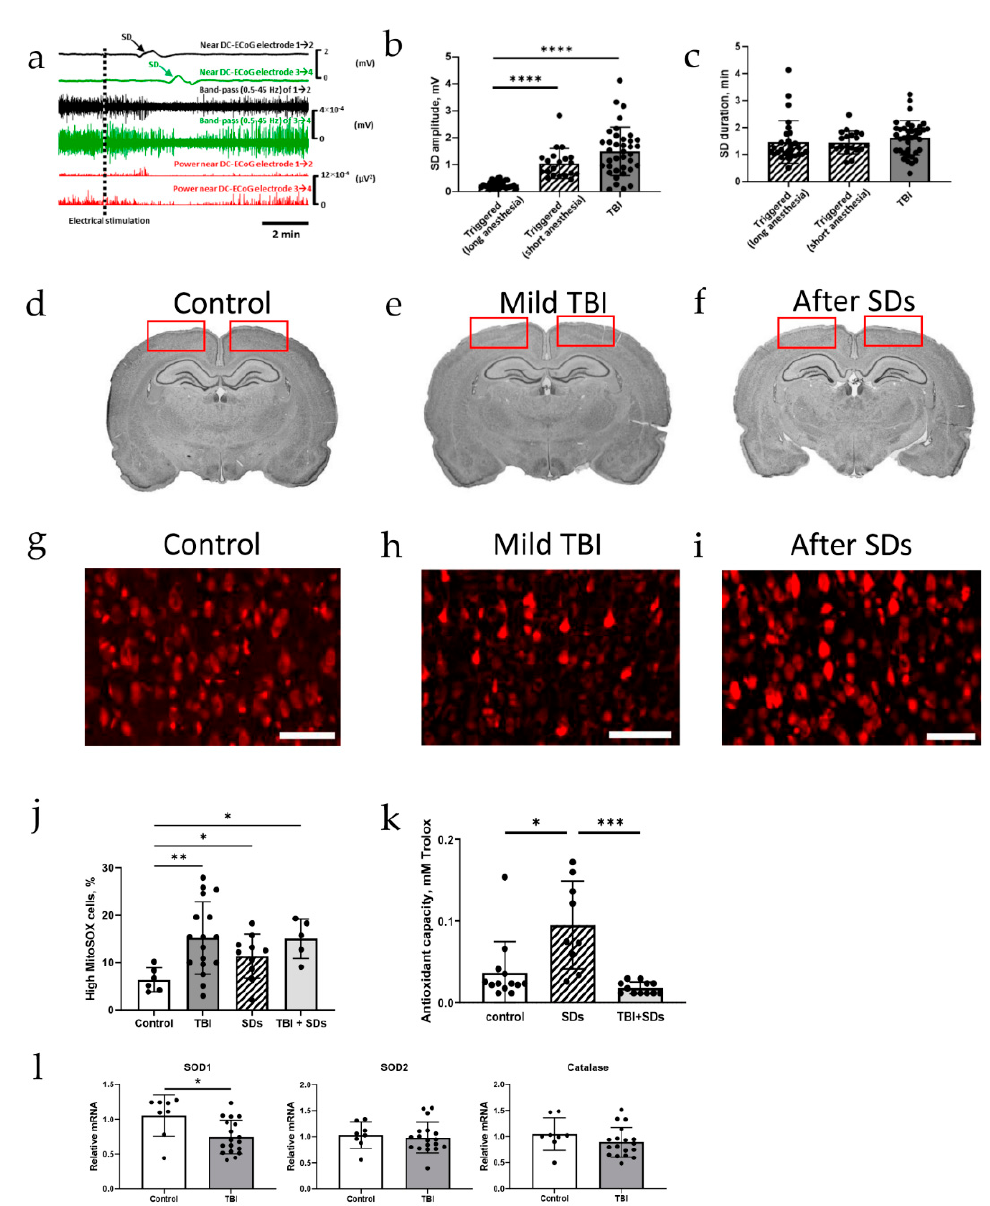
Figure 2. Changes in reactive oxygen species and antioxidant capacity after TBI or spreading depolarizations. ( a ) Recordings from both the right (black) and left (green) hemispheres, and power near DC-ECoG (red) of both hemispheres after electrical stimulation; SDs are triggered in both hemispheres. ( b ) Triggered SDs are lower in amplitude when the rat has been under anesthesia for a longer duration ( p < 0.0001, Dunn’s test); TBI-induced SDs are higher in amplitude than triggered SDs ( p < 0.0001, Dunn’s test); each dot represents 1 triggered SD or TBI impact. ( c ) Triggered SDs and TBI-induced SDs are equal in duration. ( d – f ) Cresyl staining showing no structural damage following mild TBI or triggered SDs; regions where MitoSOX fluorescence was measured are indicated by the red rectangles. ( g – j ) MitoSOX staining results in high-fluorescent-intensity cells in fixed tissue; the percentage of high-MitoSOX cells is higher after mild TBI compared to controls ( p = 0.0013, Dunnett’s test); SDs are associated with more MitoSOX fluorescence ( p = 0.044, Dunnett’s test); SDs in TBI-exposed animals also show more MitoSOX fluorescence than controls ( p = 0.0185, Dunnett’s test), with no difference compared with naïve animals exposed to SDs ( p = 0.16, Tukey’s test); each dot represents 1 animal. Scale bar = 200 µ m. ( k ) Antioxidant capacity increases after triggered SDs ( p = 0.0189, Dunn’s test), unless triggered SDs were preceded by TBI ( p = 0.38, Dunn’s test); each dot represents 1 animal. ( l ) SOD1 mRNA expression is decreased in repetitive mild TBI-impacted rats ( p = 0.0105, unpaired T -test), but catalase ( p = 0.22) and SOD2 ( p = 0.68) mRNA expression are not affected by mild TBI; each dot represents 1 animal. * p < 0.05, ** p < 0.01, *** p < 0.001, and **** p <